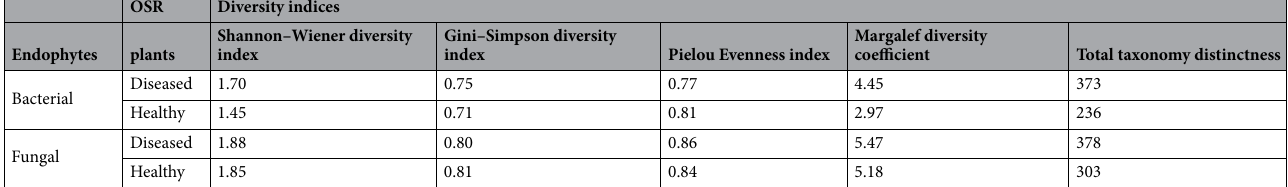
Table 1. Diversity indices of culturable bacterial and fungal communities in healthy (symptomless) and diseased (with symptoms of Phoma stem canker) OSR assessed at the genus level. Total taxonomy distinctness was calculated according to Clarke and Warwick 68